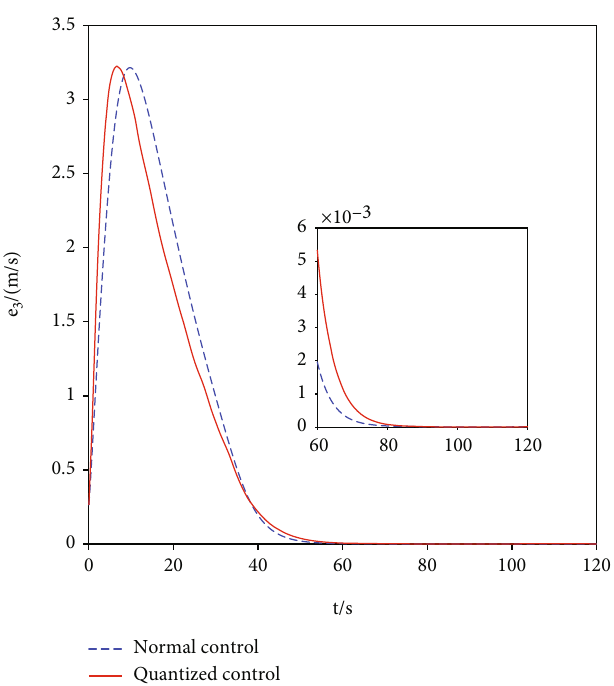
Figure 20: Relative translational velocity error